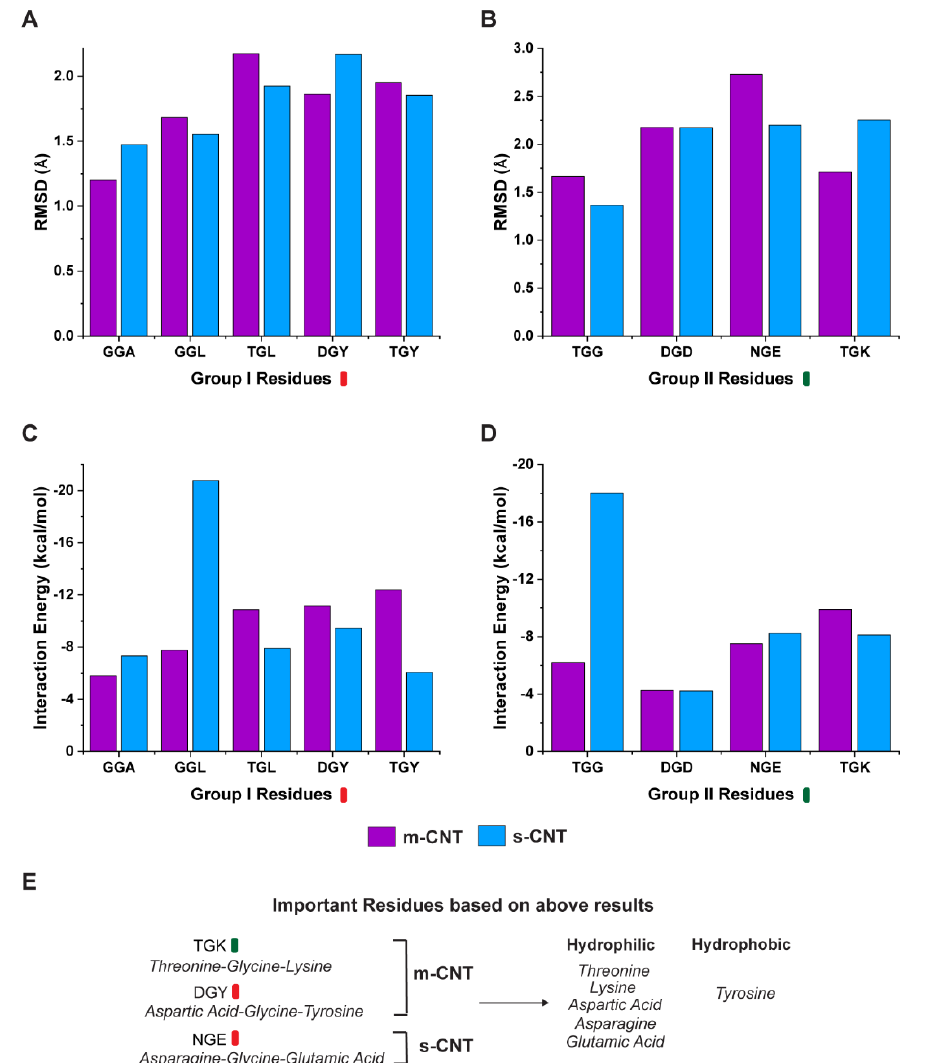
Figure 2. Change in average RMSD per frame for the tripeptide combinations in ( A ) Group I and ( B ) Group II with respect to the metallic and semiconducting CNTs. ( C , D ) show the average interaction energies per frame after the stabilization of RMSD for the two groups with respect to both CNTs. ( E ) The important residues based on the results of RMSD and interaction energy of the whole tripeptides with CNTs.